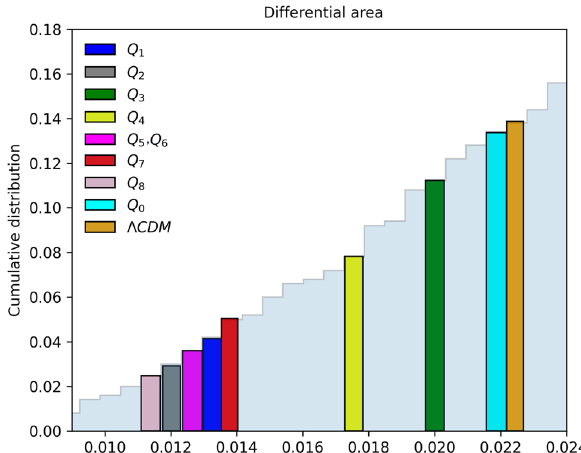
Fig. 2 This figure depicts the cumulative distribution of the differen- tial area (cid:10) A (cid:9) , as calculated from (25), and whose numerical results are reported in Table 2 together with the optimal values for the model free parameters. The specific forms of the dark energy–dark matter interac- tion terms Q 1 ,..., Q 8 can be found in Eqs. (12), ..., (19) respectively. The notation Q 0 refers to the scenario in which no energy flow between the two components of the dark sector are assumed. A lower value of (cid:10) A (cid:9) indicates that the corresponding interaction term is favoured by the cosmic chronometers data. As a term of comparison we exhibit also the result for the (cid:2) CDM model. The cosmological consequences of these results are explored in Table 3, where the corresponding values for the present day deceleration parameter, adiabatic speed of sound inside the dark energy fluid, and effective equation of state parameters for dark energy and dark matter are exhibited. We refer as well to Sect. 5.2